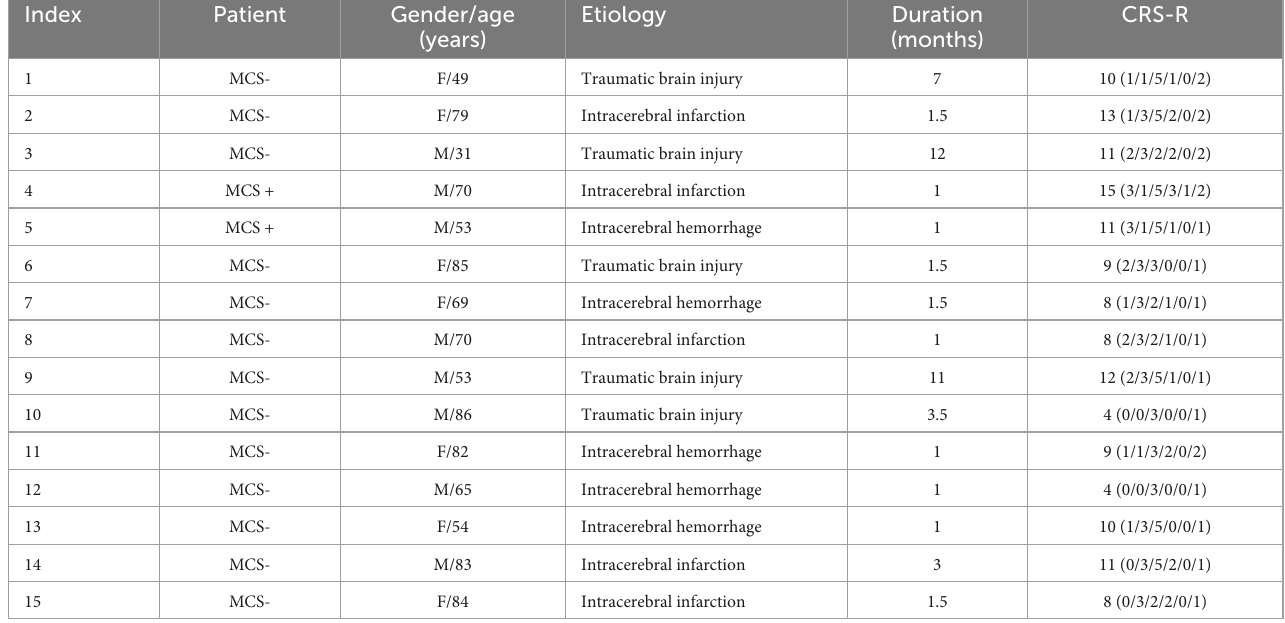
TABLE 1 Demographic and clinical data of MCS